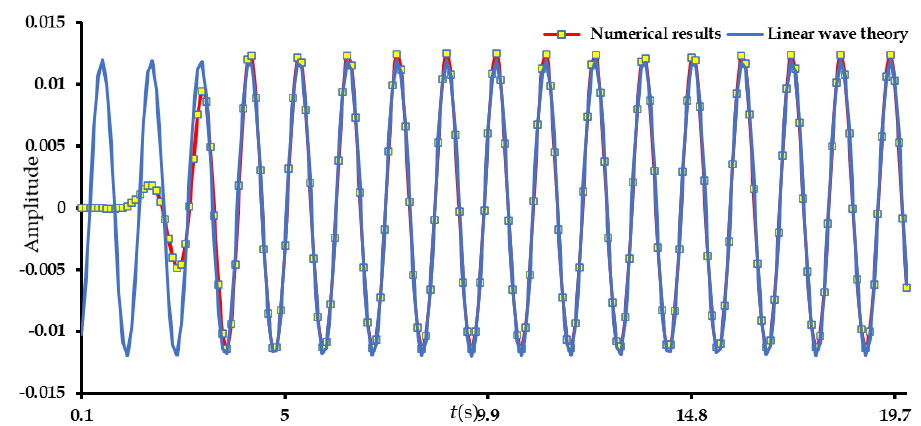
Figure 3. Time histories of the wave elevations obtained by the numerical simulation and by the linear wave theory.